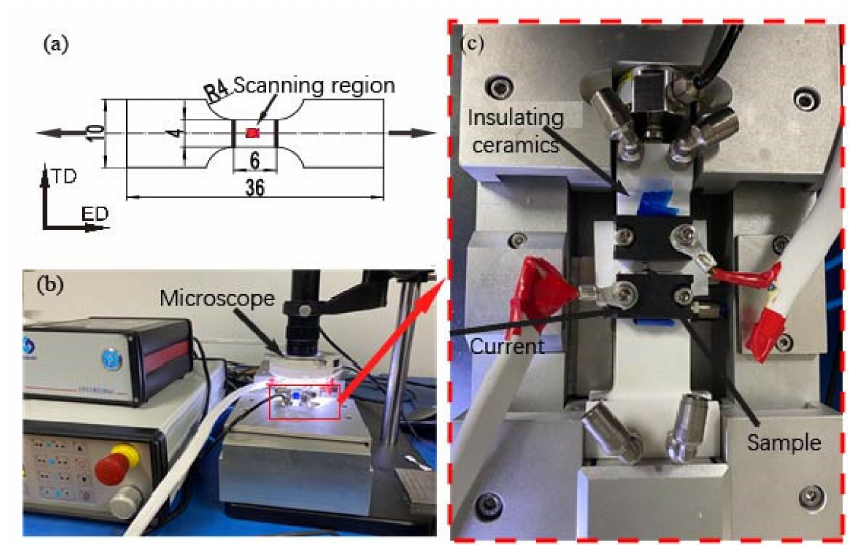
Figure 1. ( a ) Schematic of dog bone-shaped samples for EA uniaxial tensile tests; ( b , c ) the EA micro-tension